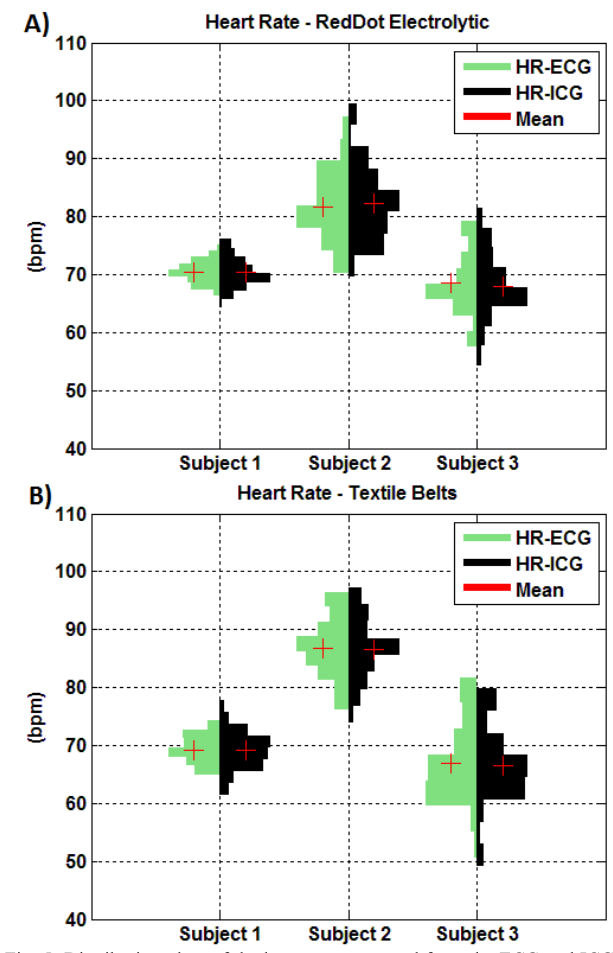
Fig. 5 Distribution plots of the heart rate extracted from the ECG and ICG signals with the corresponding mean values. In (A) HR from electrolytic electrodes and (B) from textile